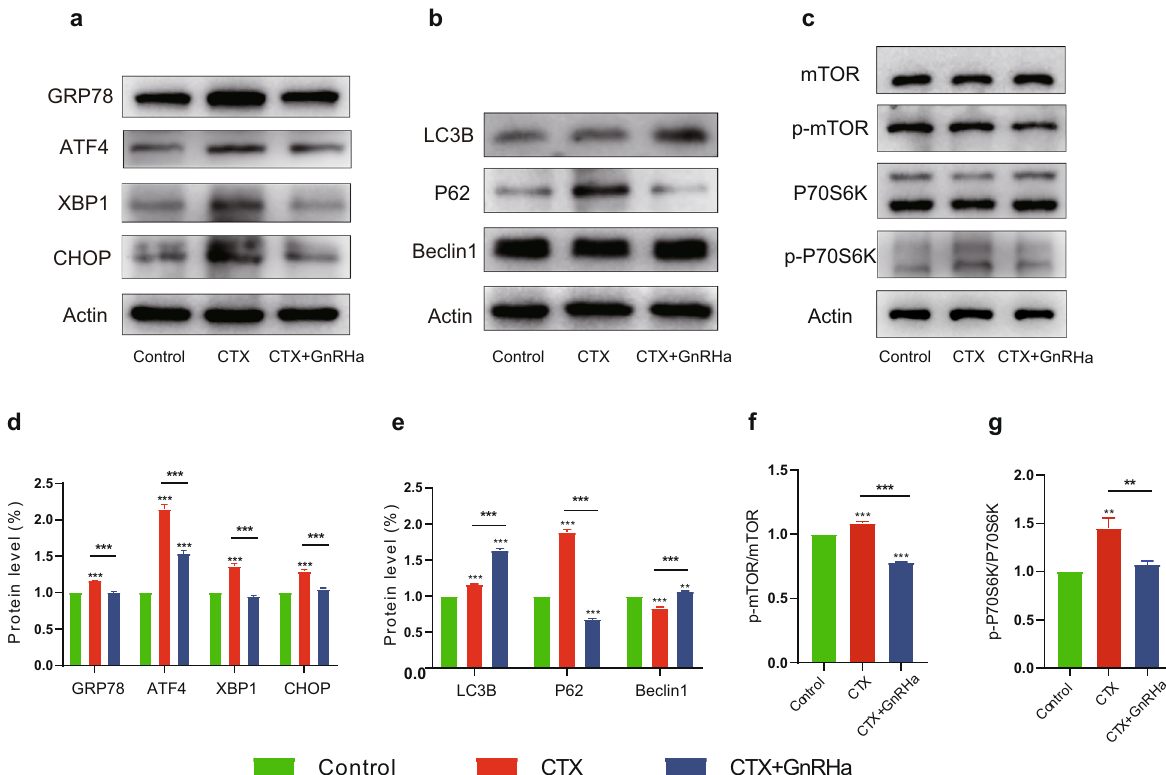
Fig. 7 GnRHa relieves ER stress by inhibiting mTOR pathway to induce autophagy in CTX-treated mice. To explore the effect of CTX and/or GnRHa on mouse ovaries, 8-week-old tumor-bearing nude mice were treated with saline, 200 mg/kg CTX, and 200 mg/kg CTX + GnRHa, and ovarian protein were extracted 1 week after treatment. a Expression of proteins in the ER stress pathway was assessed by western blotting. b Expressions of proteins in the autophagy were assessed by western blotting. c Expressions of proteins in the mTOR pathway were assessed by western blotting. d The GRP78, ATF4, XBP1, and CHOP increased signi fi cantly in CTX-treated ovaries than the control or CTX + GnRHa group. e Compared with CTX-treated mice, LC3B and Beclin-1 were increased, and P62 was decreased in coadministration with GnRHa mice. f , g The phosphorylation of mTOR and P70S6K were signi fi cantly increased in ovaries of CTX alone treated mice. Data are expressed as mean ± SD of three independent experiments. All error bars represent the standard error of the mean. Two-tailed Student ’ s t test was used for statistical analysis, * P < 0.05, ** P < 0.001, and *** P <